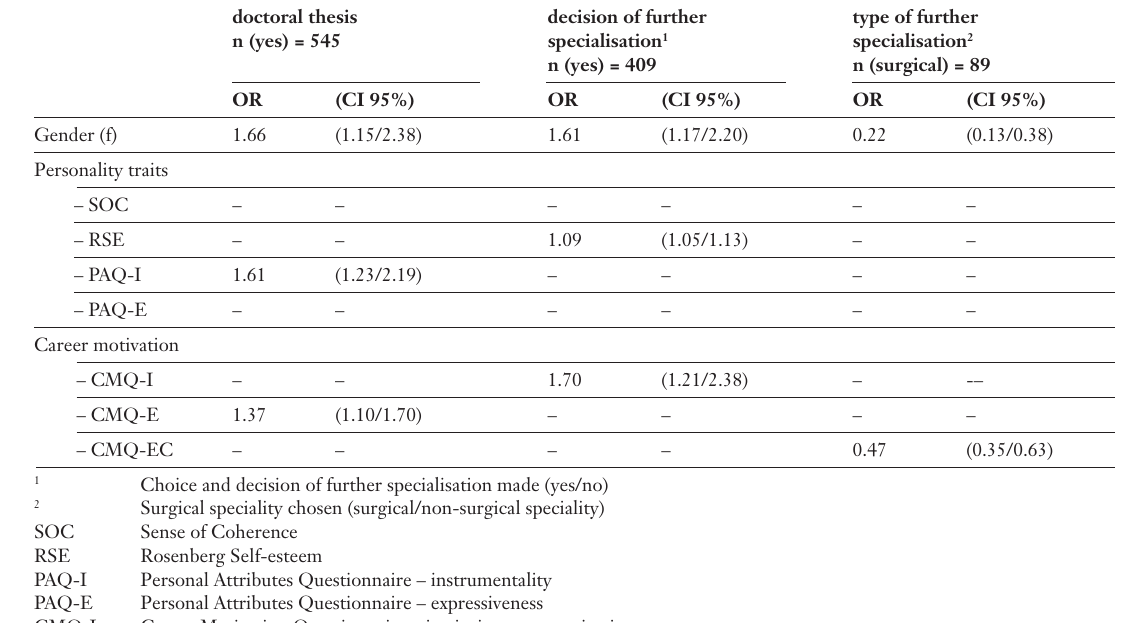
Determinants of pre- diction of advanced status of thesis, of having made the de- cision to specialise further, and of in- tending further spe- cialisation in a surgi- cal field, by logistic regression analyses (backward stepwise